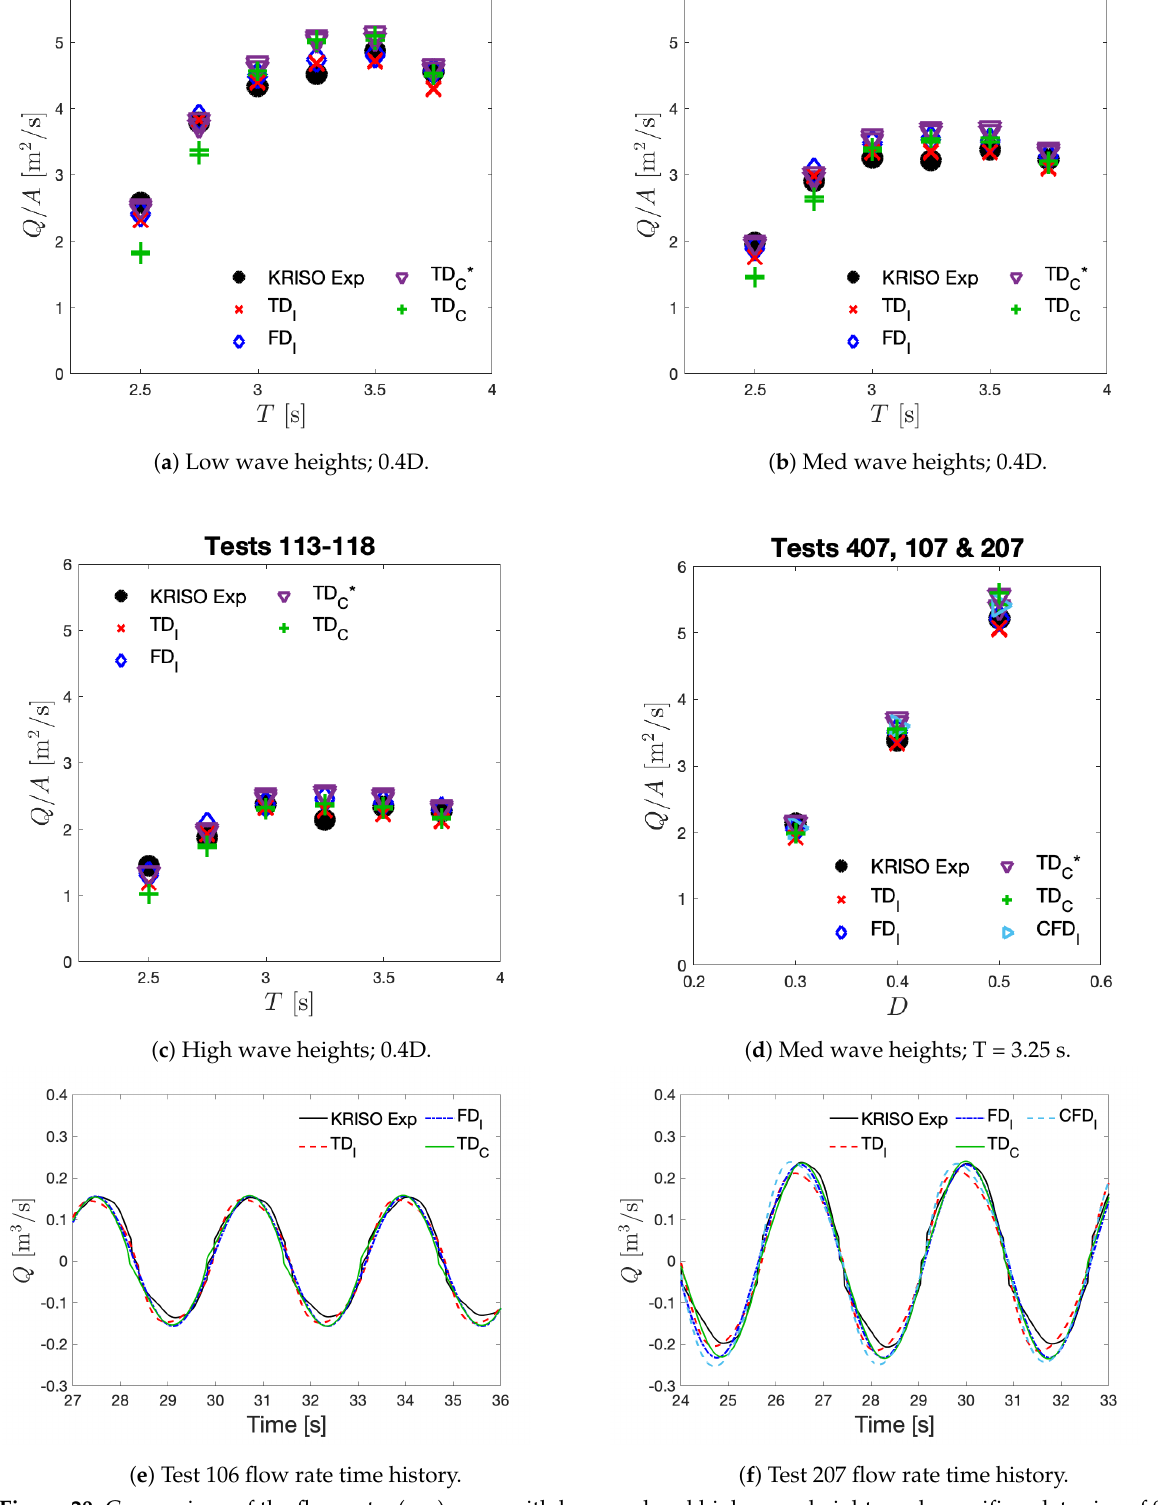
Figure 20. Comparison of the flow rate: ( a – c ) cases with low, med and high wave heights and an orifice plate size of 0.4D; ( d ) tests with orifice plate sizes corresponding to 0.3 D , 0.4 D , and 0.5 D in med wave height; and ( e , f ) flow rate time history for Tests 106 and